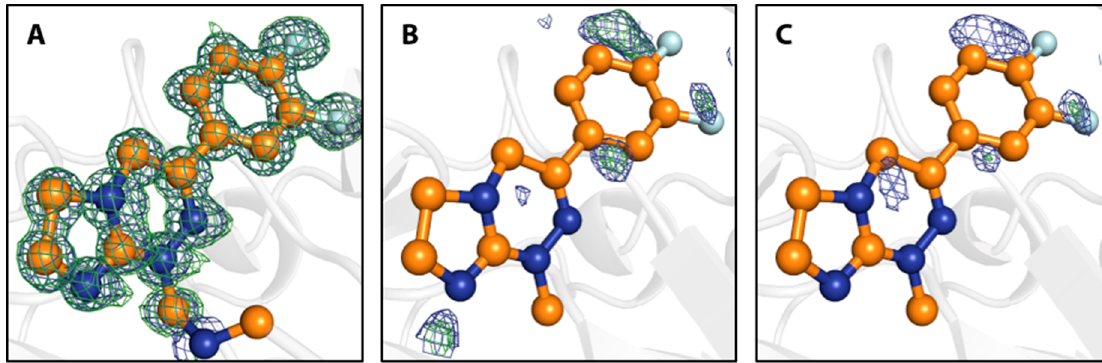
Figure 4. Close-up of the binding site of 7 with electron density maps shown at 1 σ (2mFo - DFc, blue) and 3 σ (mFo - DFc, green). ( A ) Crystal structure of fragment 7 and putative methylene unit as covalent linker to the N -terminus, as refined in 6S9Z with omit electron density maps. ( B ) Structure obtained from a crystal soaked in the above trisodium citrate conditions in presence of DMSO. Fragment 7 and the putative methylene unit from 6S9Z, as shown in A , are superimposed. Electron density maps are shown after automated refinement and indicate that 7 does not bind under these conditions. ( C ) Same as B , but for a crystal soaked in the above trisodium citrate conditions in the absence of DMSO.